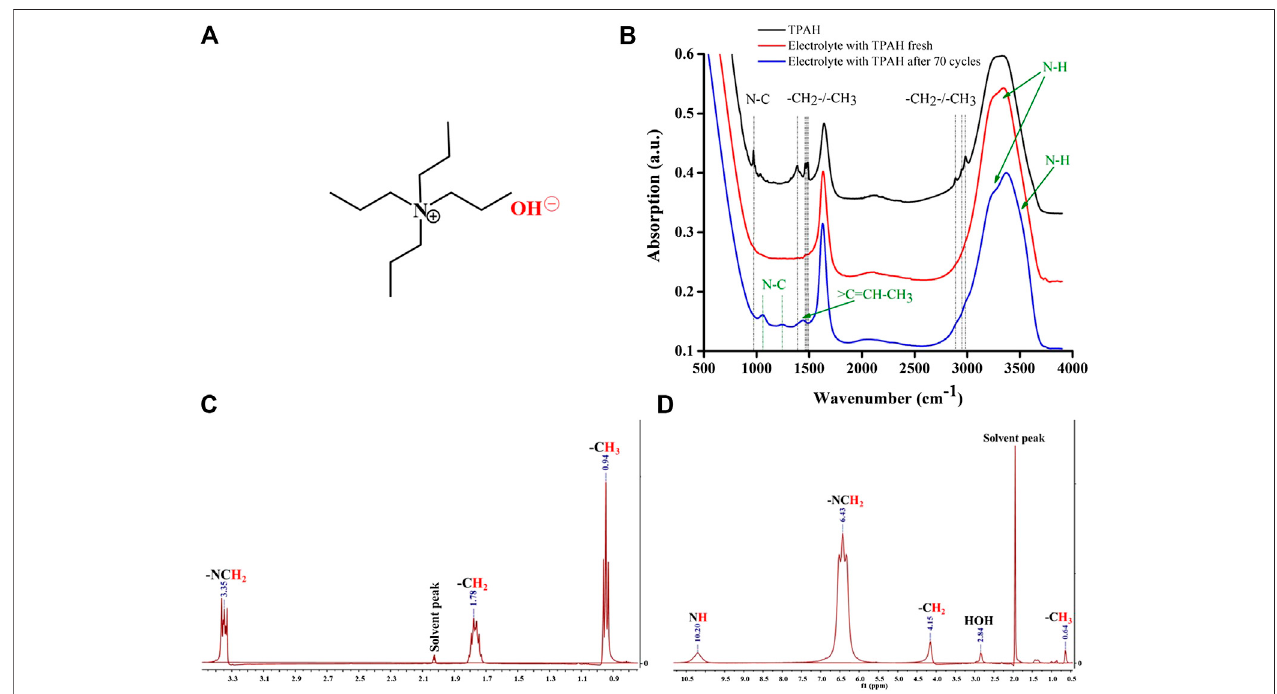
FIGURE 6 | (A) TPAH molecular structure, (B) FTIR absorption spectra of TPAH, (C) 1H NMR spectrum of 1 M TPAH commercial solution, and (D) 1H NMR spectrum of electrolyte with 0.01 M TPAH additive after cycling.